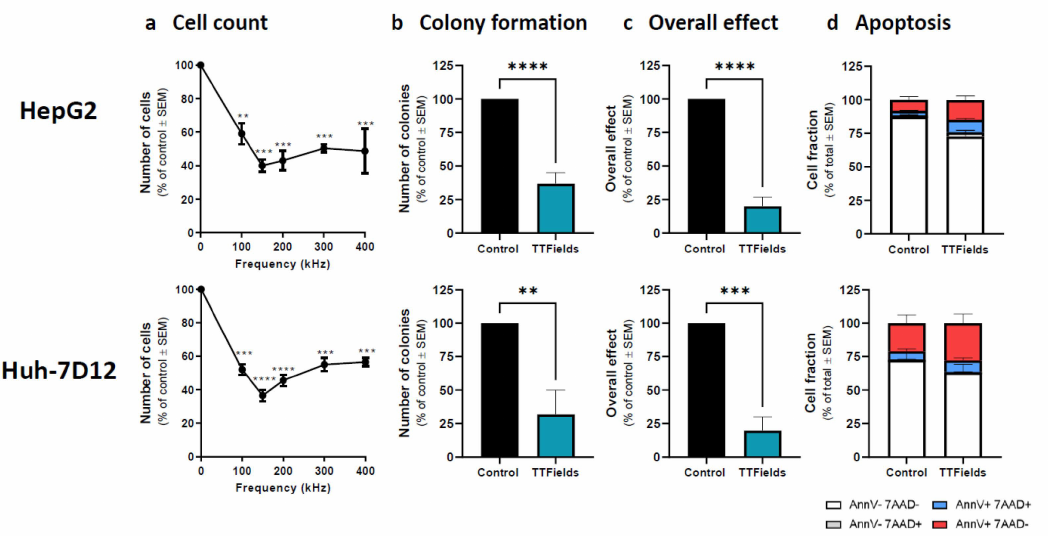
Figure 1. Efficacy of TTFields for treatment of HCC cells. HepG2 and Huh-7D12 cells were treated with TTFields (1.0 and 1.7 V/cm RMS, respectively) for 72 h. Cell counts were determined following treatment with TTFields at a frequency range of 100–400 kHz ( a ). Values are mean ( N ≥ 3) ± SEM. ** p < 0.01, *** p < 0.001, and **** p < 0.0001 relative to control; one-way ANOVA. Clonogenicity ( b ), overall effect ( c ), and apoptosis ( d ) were examined for treatment of the cells with 150 kHz TTFields. Values are mean ± SEM. ** p < 0.01, *** p < 0.001, and **** p < 0.0001 relative to control; For apop- tosis assay live cells: p < 0.05 for HepG2 and p = 0.14 for Huh-7D12 relative to control; Student’s t -test. ANOVA = analysis of variance; HCC = hepatocellular carcinoma; RMS = root mean square; SEM = standard error of the mean; TTFields = Tumor Treating